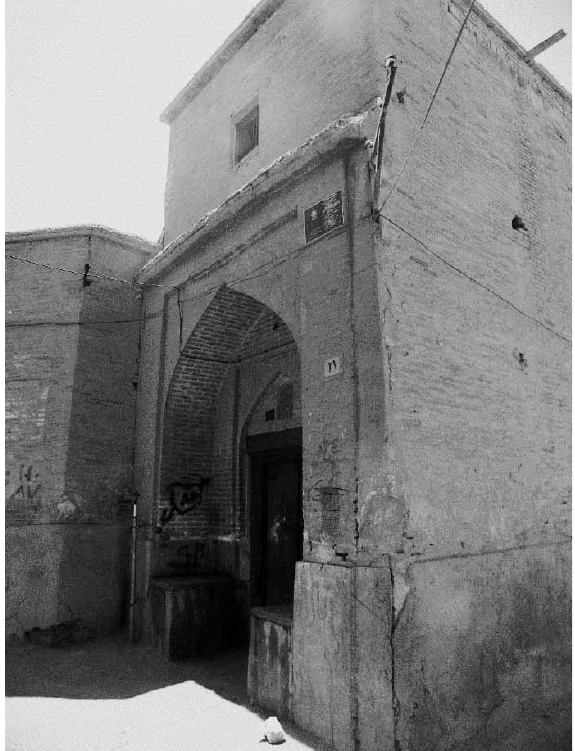
fig. 7. Entrance with seats in old district of Shiraz (photo by the